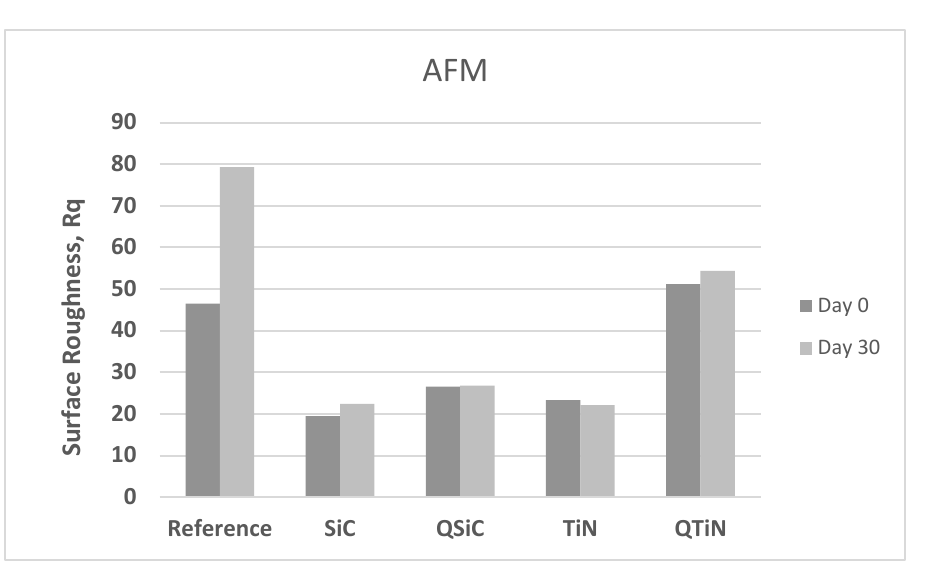
Figure 5. Roughness means values (image Rq) in non-coated (Reference) and coated (TiN, QTiN, SiC, and QSiC) disks initially (Day 0) and after 30 days in cultivation with bacteria.